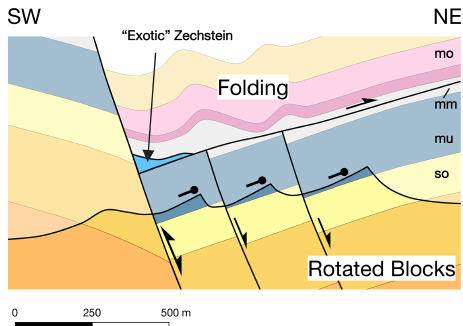
Figure 9. Schematic model of the relation between a lower struc- tural level with rotated blocks and an upper structural level dom- inated by folding as a result of a detachment within the middle Muschelkalk. Faults delimiting the rotated blocks within the lower floor peter out into the middle Muschelkalk or merge into the de- tachment. Through varying degrees of erosion the different styles become visible or predominant in the different